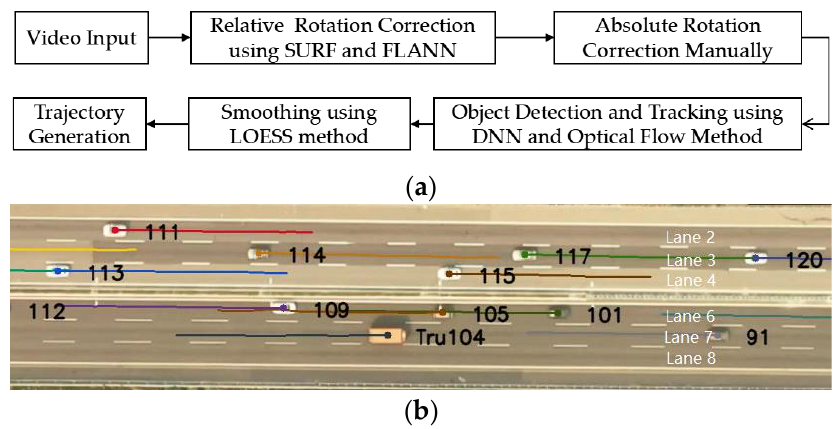
Figure 1. ( a ) Trajectory generation workflow [34] and ( b ) the detection result.